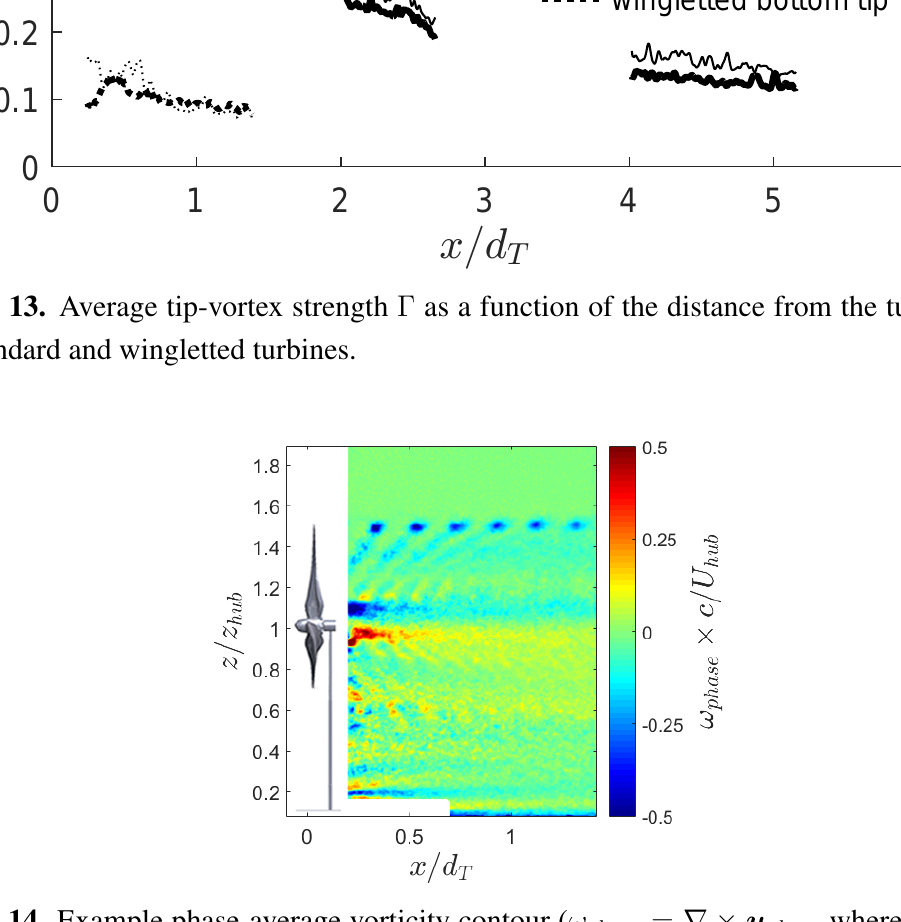
Figure 14. Example phase-average vorticity contour ( ω phase-average velocity) for the base turbine, normalized with blade chord length c and hub velocity U hub